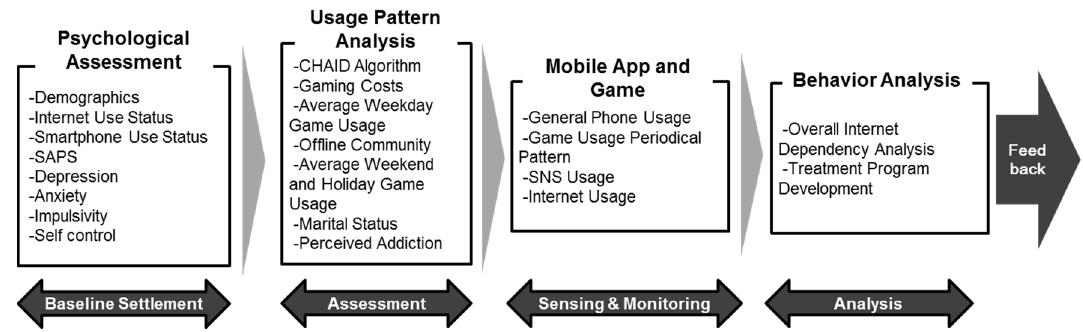
Figure 1. Total System Architecture of the Smartphone Overdependence Management System (SOMS).